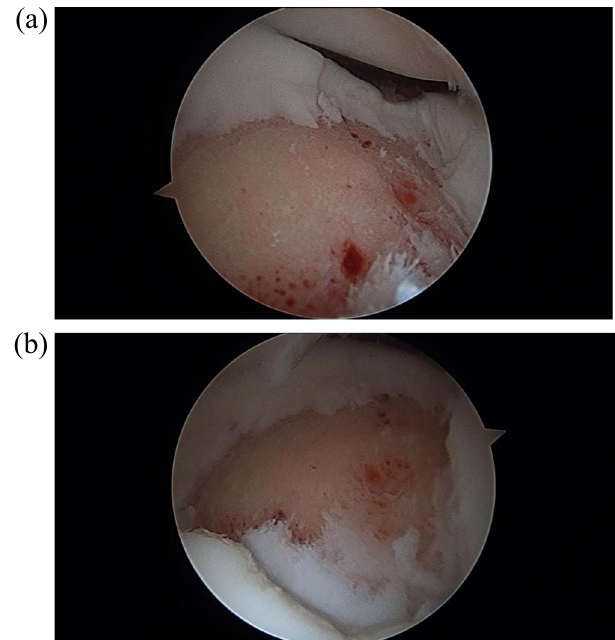
Figure 4. Intraoperative arthroscopic images showing large full- thickness cartilage defect at the lateral femoral condyle without disruption of the underlying subchondral bone (a and b).